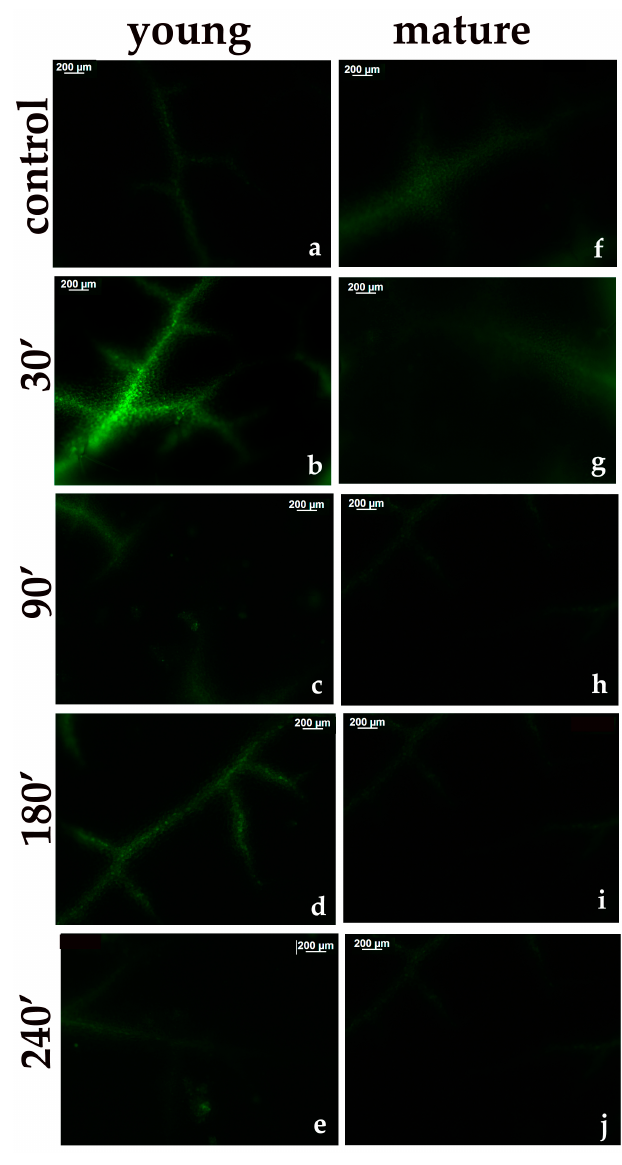
Figure 11. Representative patterns of reactive oxygen species (ROS) (H 2 O 2 ) production in Arabidopsis thaliana young ( a – e ) and mature ( f – j ) leaves, as indicated by the fluorescence of H 2 DCF-DA. The H 2 O 2 generation after the foliar spray with distilled water (control) in a young leaf ( a ) and mature leaf ( f ); or 30 min after foliar spay with 30 mg L − 1 of CuZn NPs in a young leaf ( b ) and mature leaf ( g ); 90 min after foliar spay with 30 mg L − 1 of CuZn NPs in a young leaf ( c ) and mature leaf ( h ); 180 min after foliar spay with 30 mg L − 1 of CuZn NPs in a young leaf ( d ) and mature leaf ( i ); and 240 min after foliar spay with 30 mg L − 1 of CuZn NPs in a young leaf ( e ), and mature leaf ( j ). Scale bare: 200 µ m. A higher H 2 O 2 content is indicated by the light green color. The foliar spay of Arabidopsis thaliana young and mature leaves with 30 mg L − 1 of CuZn NPs revealed a spatiotemporal heterogeneity of Φ PS ΙΙ and q P measured (at 140 μ mol photons m − 2 s –1 ) 30 min, 90 min, 180 min, and 240 min after spraying (Figures 7–10). Young leaves show a higher spatial heterogeneity (Figures 7 and 9) compared to mature leaves (Figures 8 and 10). Nevertheless, PSII function was not uniform for both leaf types, making conventional chlorophyll fluorescence